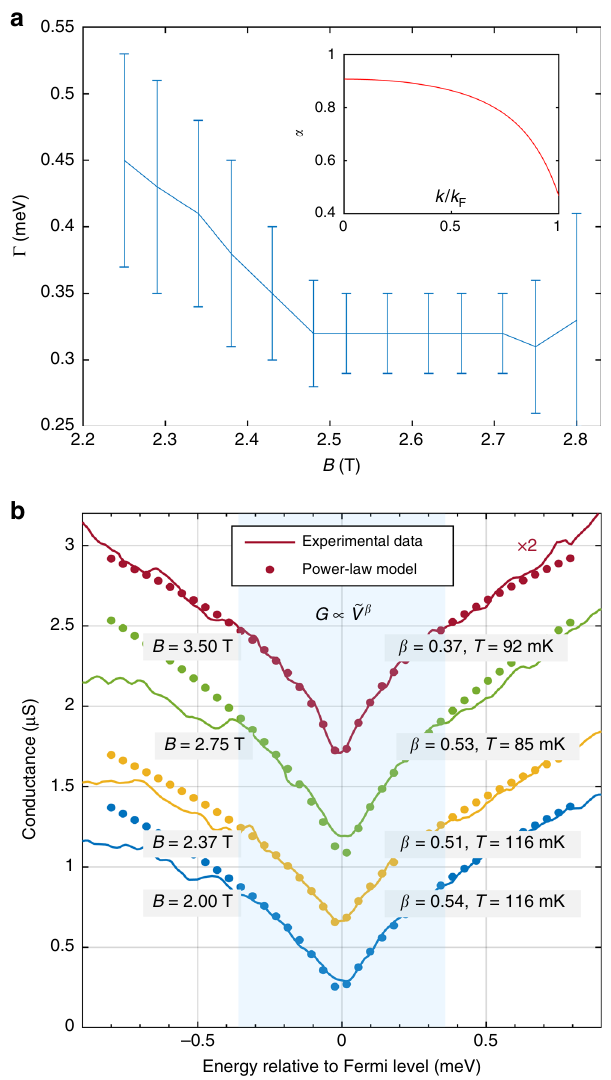
Fig. 5 Broadening and zero-bias anomaly. a Dependence of the broadening fi tting parameter Γ on fi eld B , for the full interacting calculation (model 2). The inset shows how α ( k ) varies with k , from Eq. (1). The error bars indicate the range of Γ values for which the calculated model consistently matches the experimental data around the conductance peak, by visual comparison. b Power-law fi t of the ZBA for the fi rst sample. The conductance is modelled to be of the form G ¼ a ~ V β , where ~ V